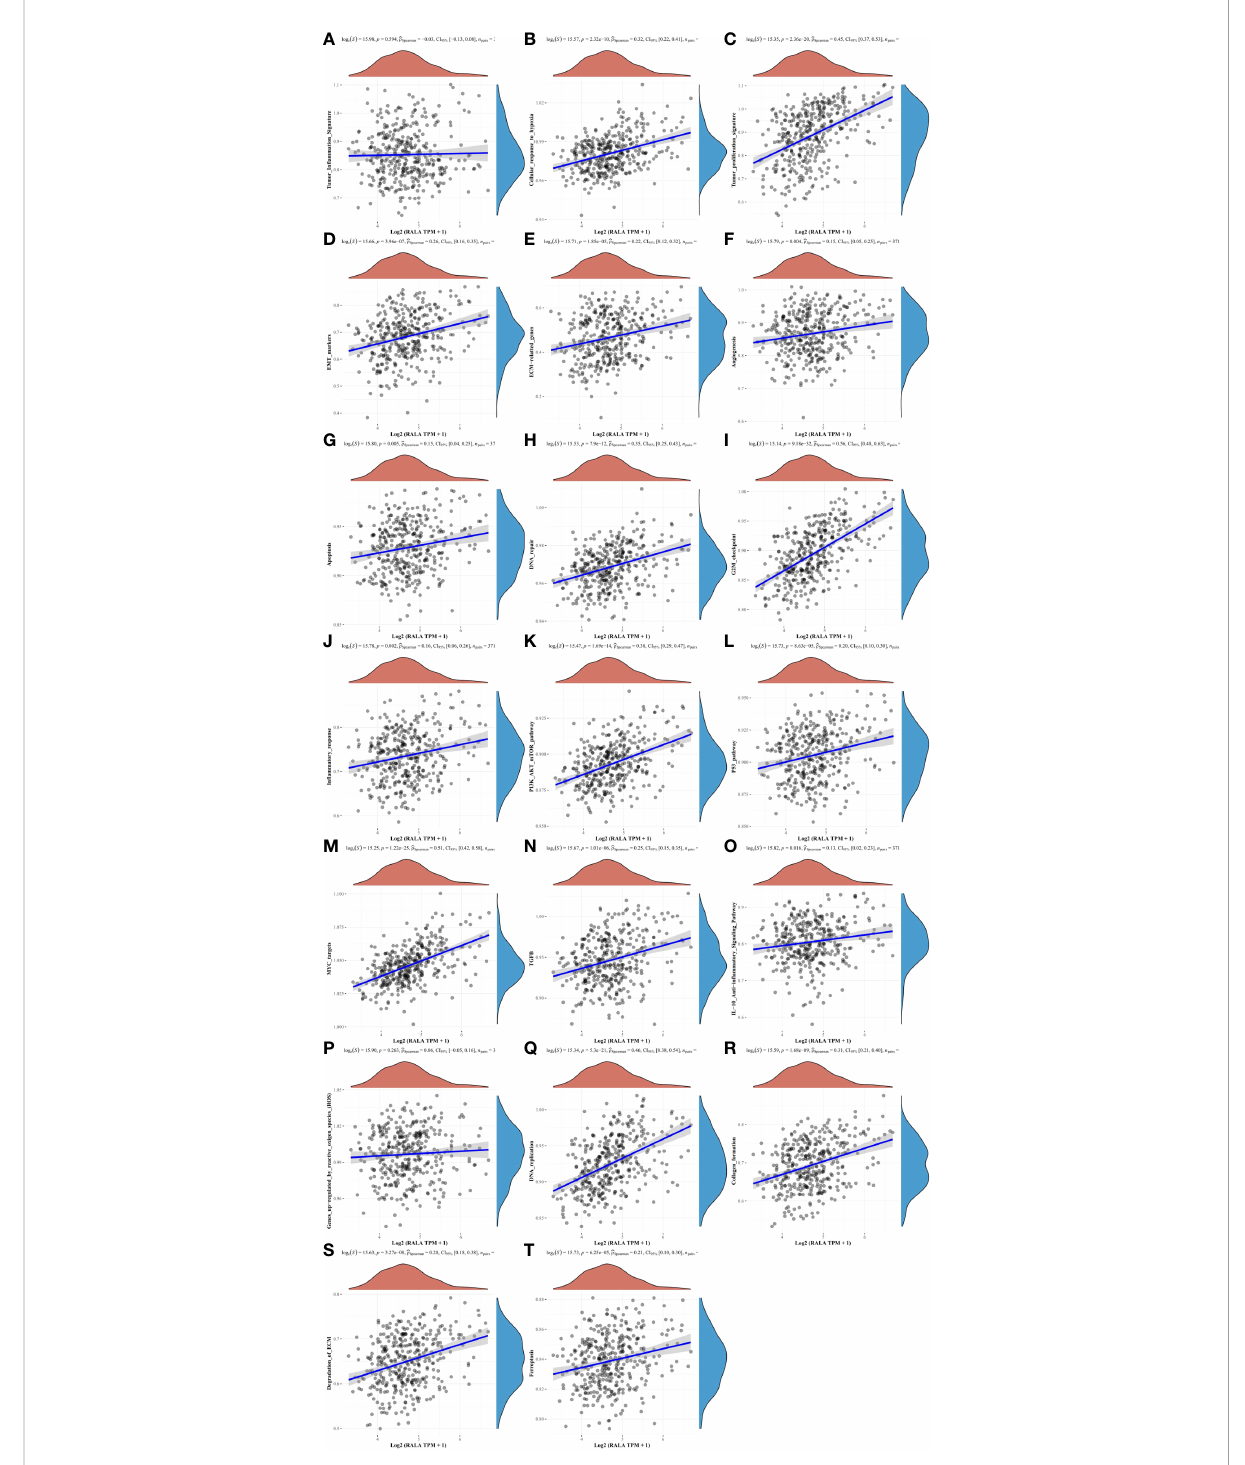
FIGURE 10 The correlation between RALA and HCC signaling pathways. (A, P) There is no signi fi cant correlation between RALA and tumor in fl ammation signature, genes up-regulated by reactive oxygen species. (B – O, Q – T) RALA is remarkable positively correlated with cellular response to hypoxia, angiogenesis and other common intracellular signaling